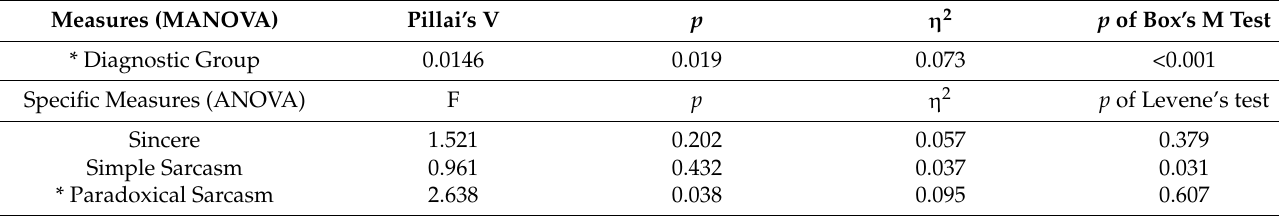
Table 2. Statistical processing results.